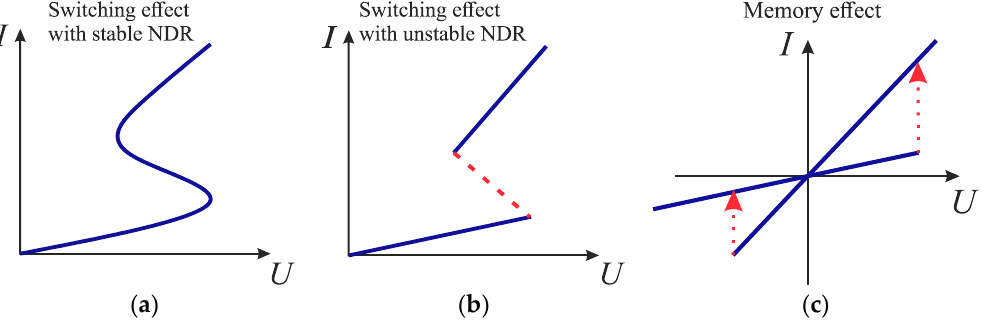
Figure 1. S-type I–V characteristic with stable NDR segments ( a ), unstable NDR segments, ( b ) and with bipolar memory effect ( c ).